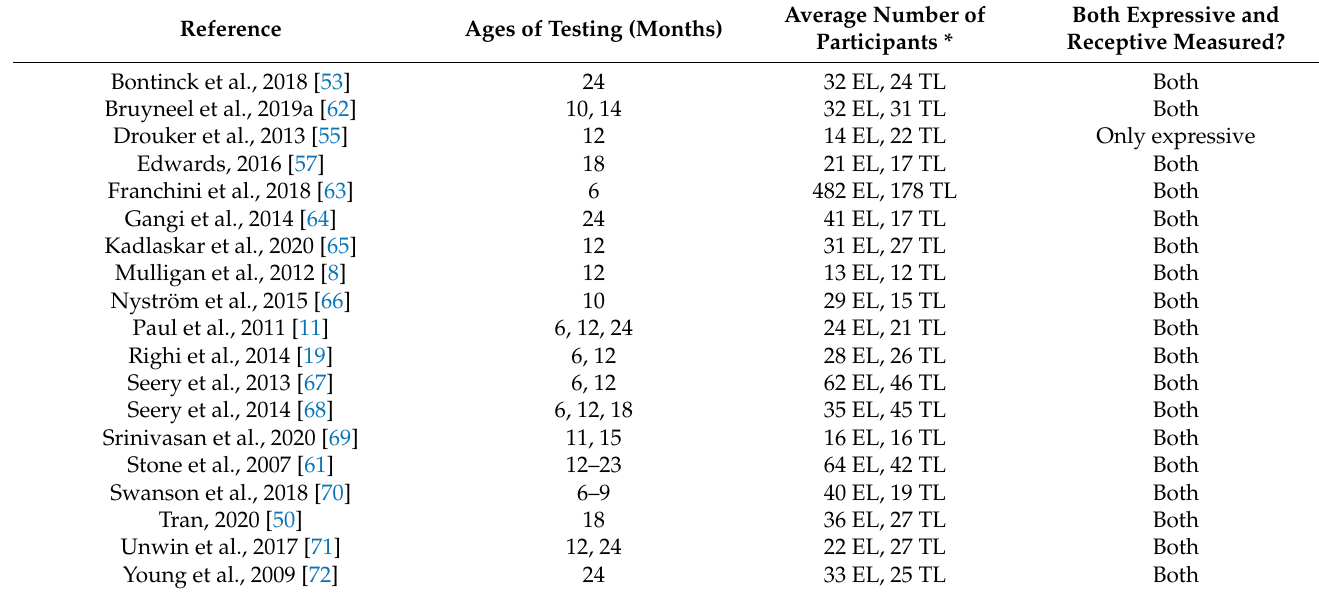
Table A2. Studies without clinical diagnosis on the Mullen Scales of Early Learning.